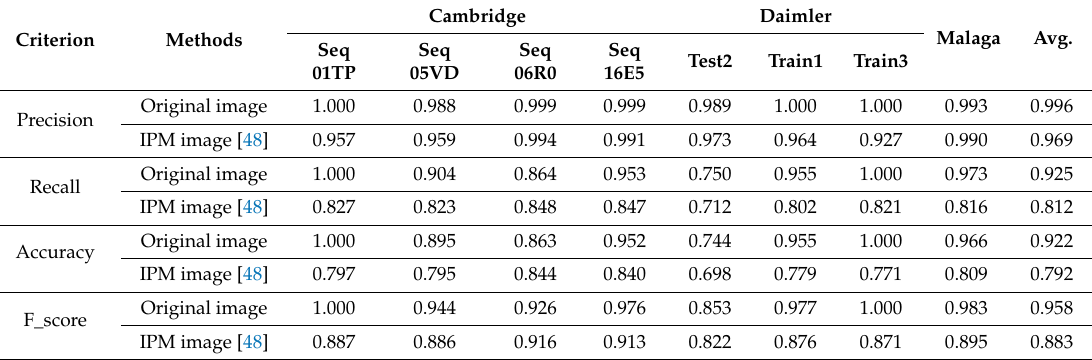
Table 8. Comparative experimental results using the original and IPM